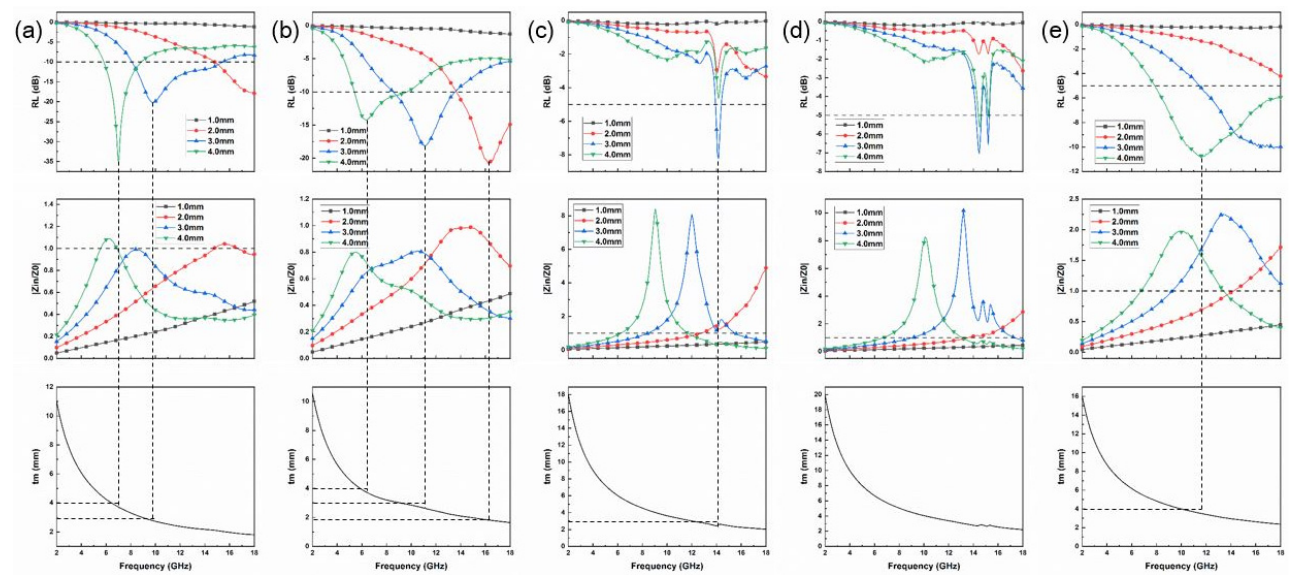
Figure 4. The specular reflection suppression of SiC fibers (reflection loss (picture in first line), impedance matching characteristics (picture in second line), the quarter-wavelength condition (picture in third line)): ( a ) S900, ( b ) S1000, ( c ) S1100, ( d ) S1200, ( e ) S0.